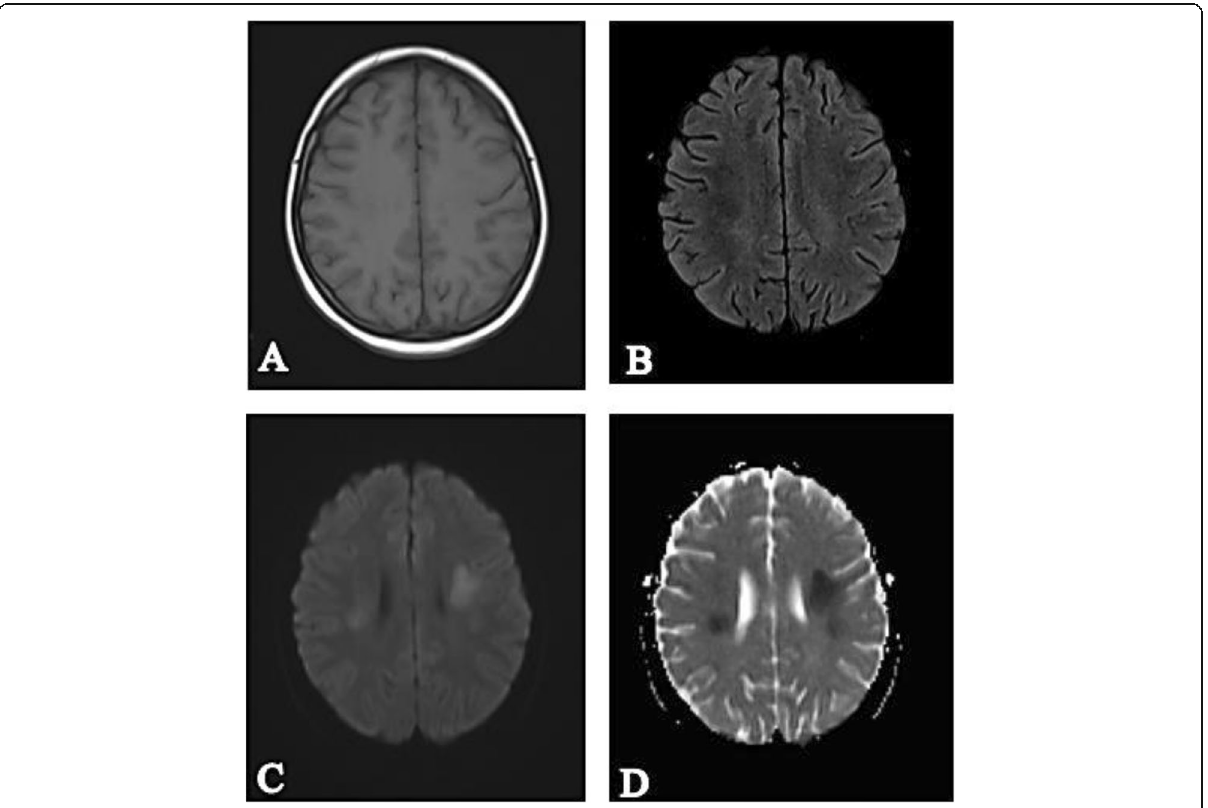
Fig. 12 MTX toxicity. Female patient, 15 years old, diagnosed with ALL at consolidation phase on methotrexate therapy. Axial MRI images of the brain at the level of fronto-parietal regions. The a T1WI, b FLAIR, c DWI, and d ADC map shows bilateral periventricular areas of diffusion restriction with no gross signal abnormalities seen at conventional T1WI or FLAIR